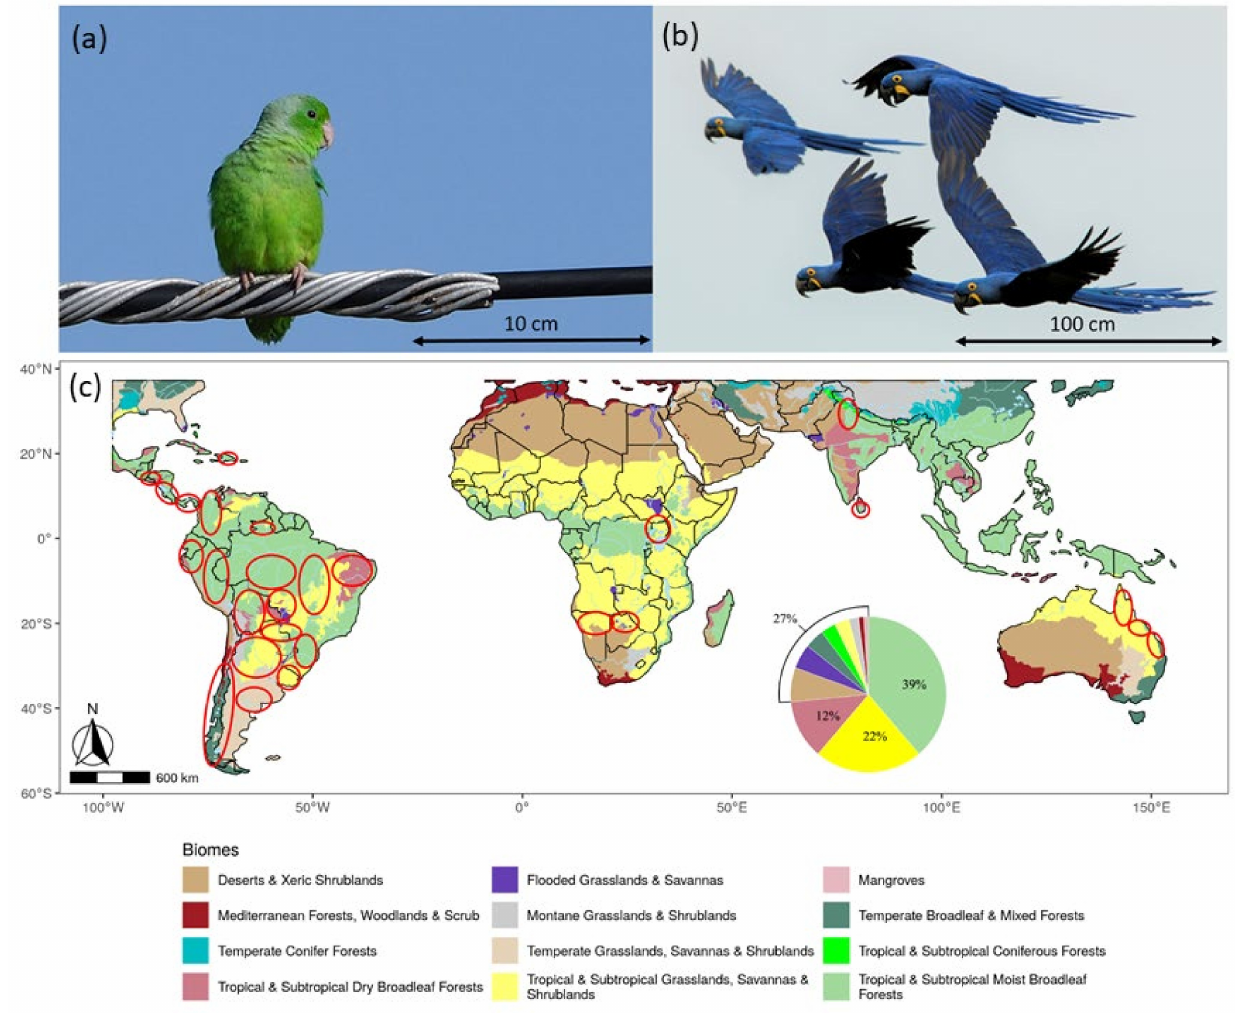
Figure 1. Roadside surveys allowed us to record from ( a ) the smallest (green-rumped parrotlet Forpus passerinus) to ( b ) the largest parrot species (hyacinth macaws Anodorhynchus hyacinthinus) through 98 surveys conducted in 20 countries ( c ). The surveyed areas are roughly depicted with red ellipses over the world biomes. Each area may include several surveys, biomes, and ecoregions. The inserted pie chart shows the percentage of surveys conducted within each biome. Photographs: Jos é L.